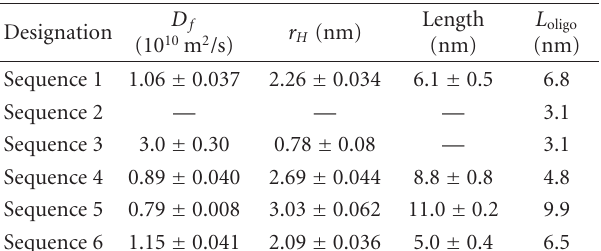
Table 2: Hydrodynamic parameters obtained from DLS measure- ments in dialysed samples at 0.4 mM DNA concentration and room temperature. The length of the quadruplex L is estimated from (6) using d = 2 . 6nm for the quadruplex diameter [26, 39]. For comparison, the length of extended oligonucleotides L oligo is estimated by multiplying the number of bases with 0.34 nm, the average base distance.